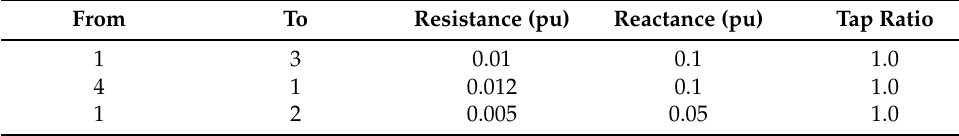
Figure 12. Evolution of the parameter p for the control scheme of each generator: ( a ) p 1 ; ( b ) p 2 . Table 6. Line data.